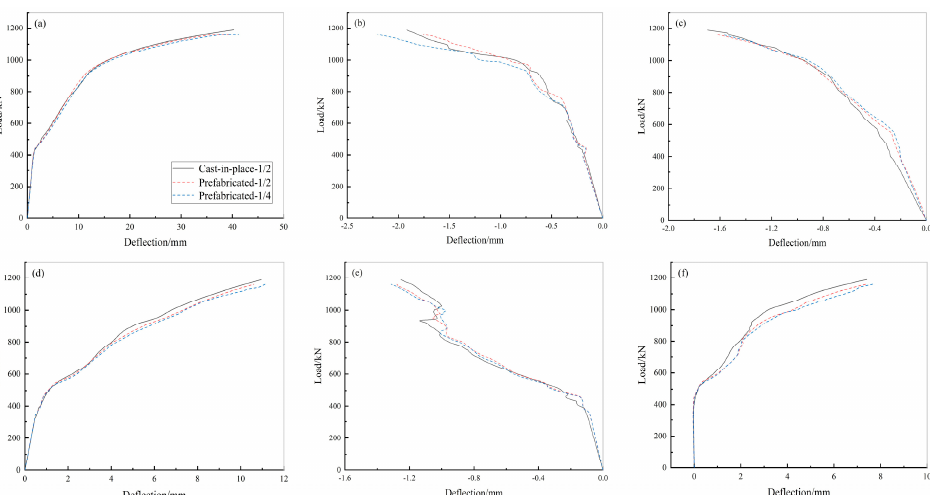
Figure 17. Load-deflection curves of double-section cast-in-place and prefabricated underground utility tunnels: ( a ) load-deflection curve of large-span top plate; ( b ) load-deflection curve of small-span top plate; ( c ) load-deflection curve of large-span lateral wall; ( d ) load-deflection curve of large-span bottom plate; ( e ) load-deflection curve of small-span bottom plate; and ( f ) load-deflection curve of small-span lateral wall.